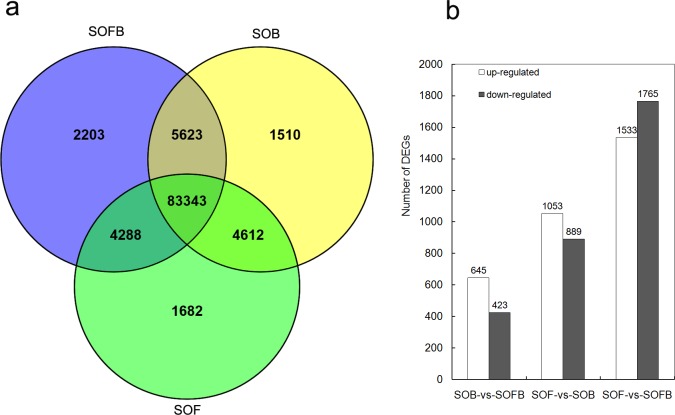
Distribution of genes among each flower developmental stage.a: Venn diagram illustrating the expression patterns of genes among flower developmental stages. b: Number of DEGs in each flower developmental stage. DEGs are compared between developmental stages. SOFB, flower bud stage; SOB, bud stage; SOF, flowering stage.